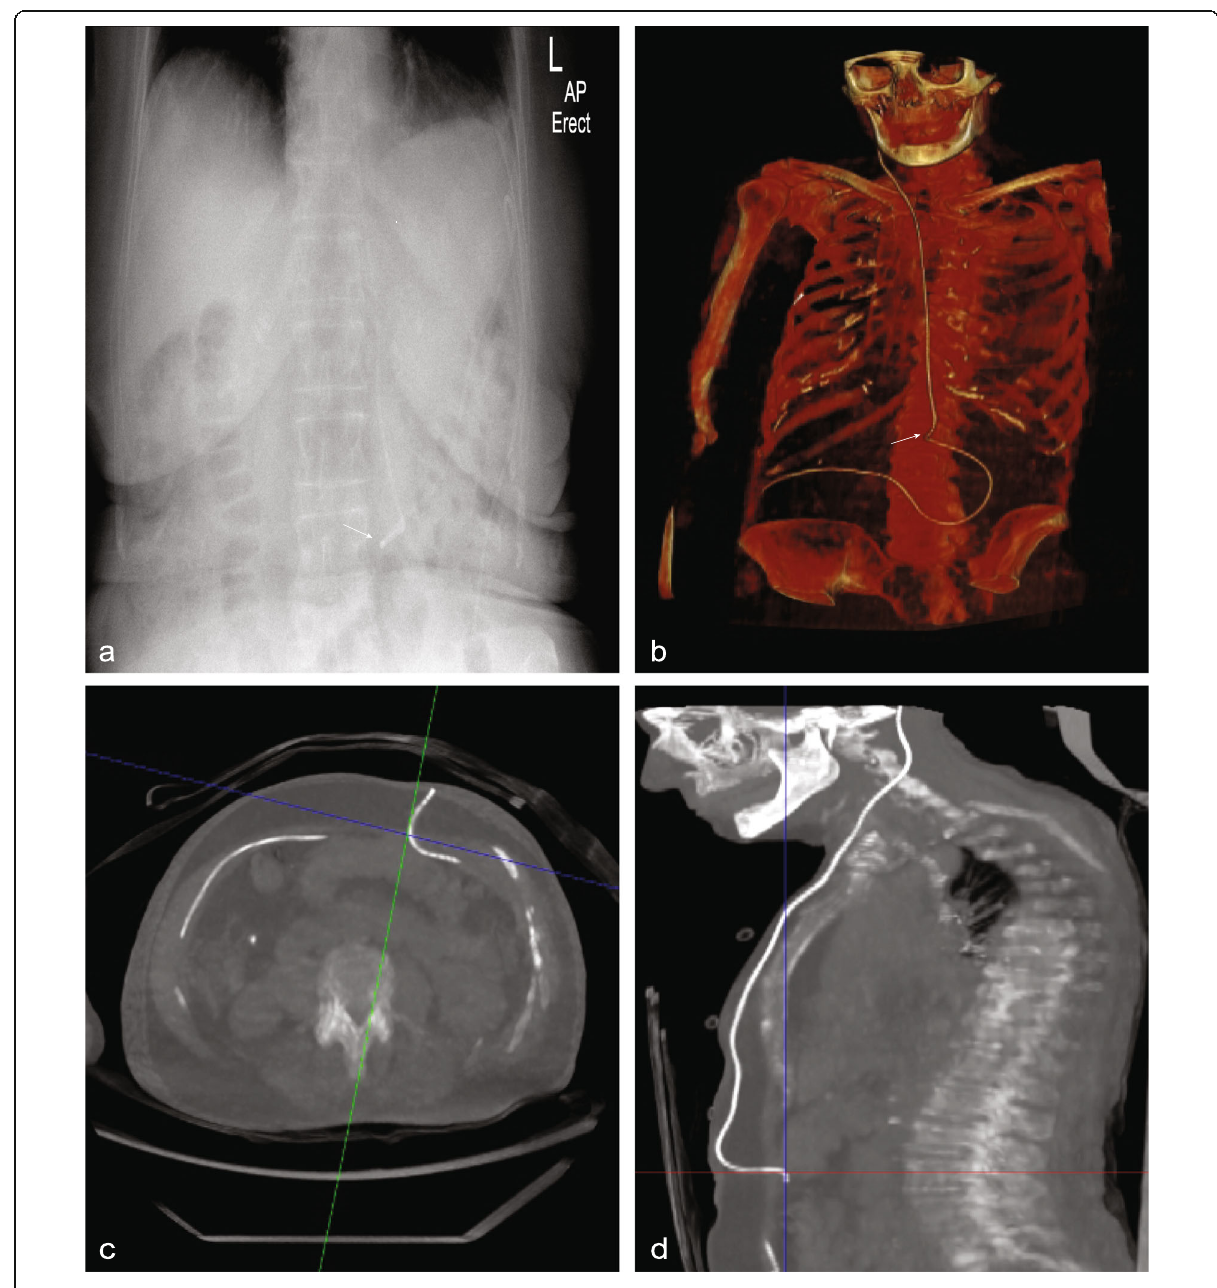
Fig. 6 Specificity of ULD CT with pure IR for shunt evaluation. Abdominal radiograph portion of a plain radiographic shunt series (PRSS) demonstrating a kink in the shunt tube ( arrow in a ). ULD CT with pure IR three-dimensional reconstruction confirming the presence of a contour change in the shunt tubing at the corresponding level ( arrow in b ). Axial (42-mm reconstructed slice thickness) and coronal (34-mm reconstructed slice thickness) ULD CT images showing that the ‘ kink ’ seen on plain radiograph correlates with the peritoneal entry site of the shunt and was therefore a false positive ( c and d ). CT Computed tomography, IR Iterative reconstruction, PRSS Plain radiographic shunt series, ULD Ultralow